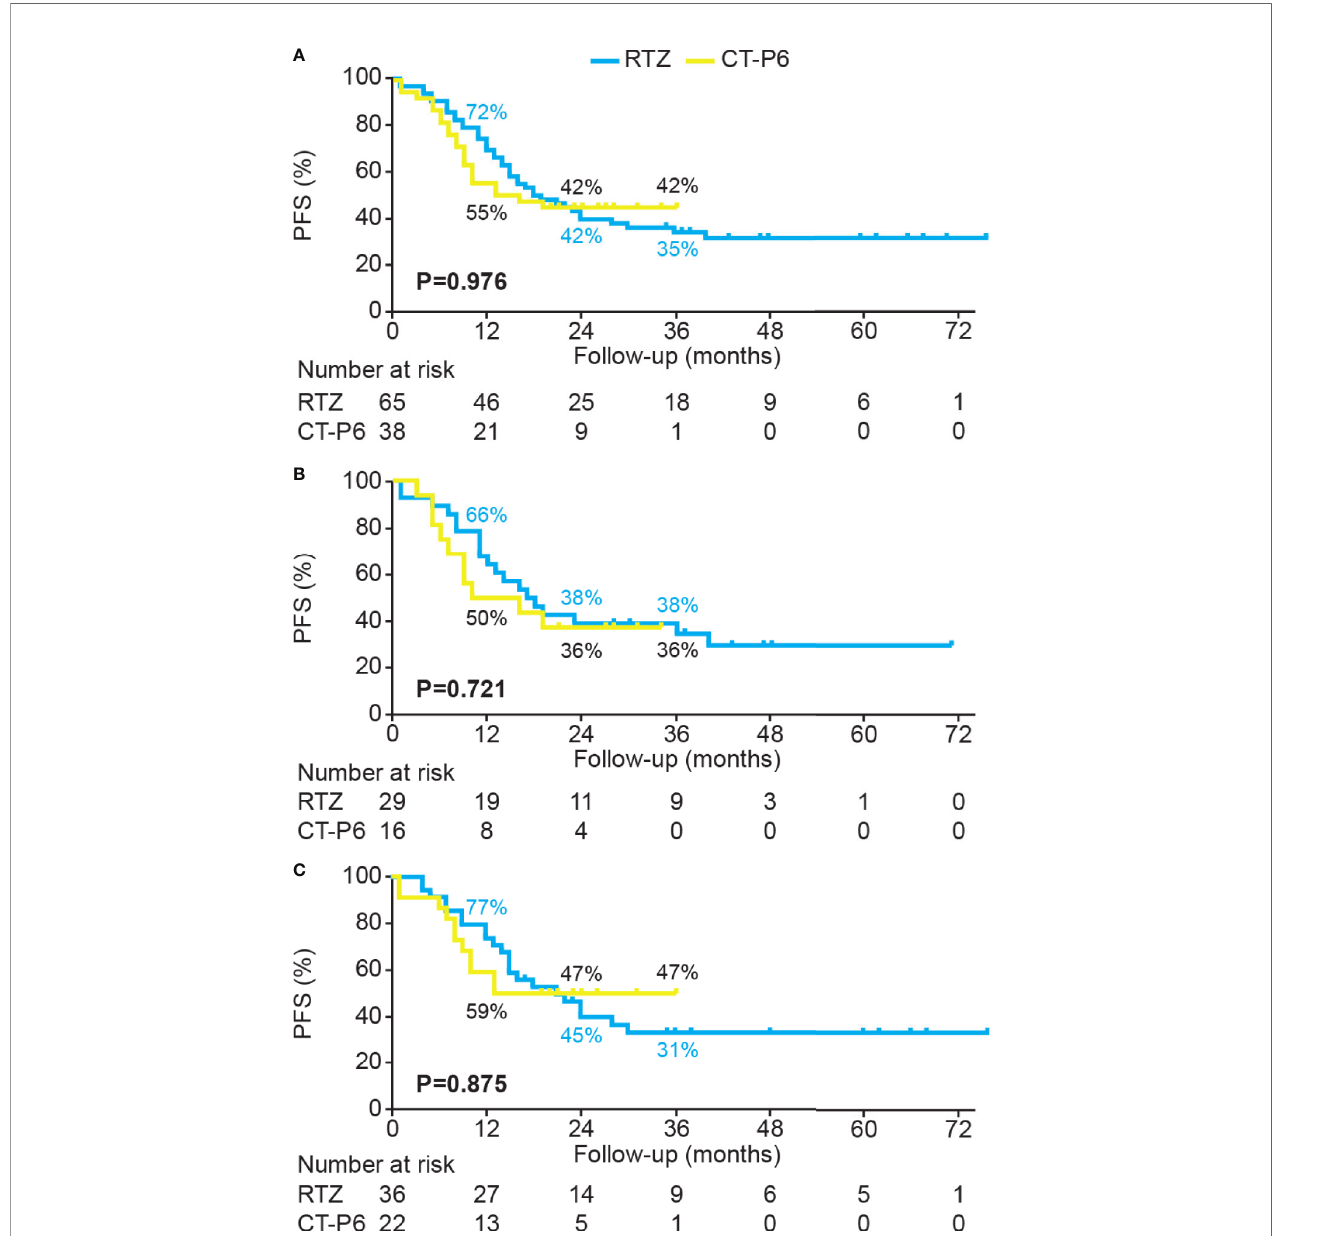
FIGURE 3 | PFS for HER2-positive metastatic breast cancer patients who received palliative treatment with CT-P6 or RTZ for (A) all patients, (B) HR+/HER2+ patients, and (C) HR − /HER2+ patients. HER2, human epidermal growth factor receptor 2; HR, hormone receptor; PFS, progression-free survival; RTZ, reference